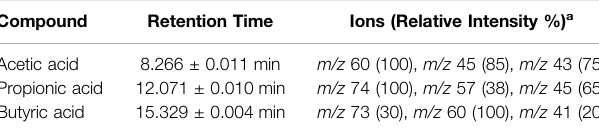
TABLE 4 | GC-MS retention time data and diagnostic ions for SCFA reference standards ( n = 3). Compound Retention Time